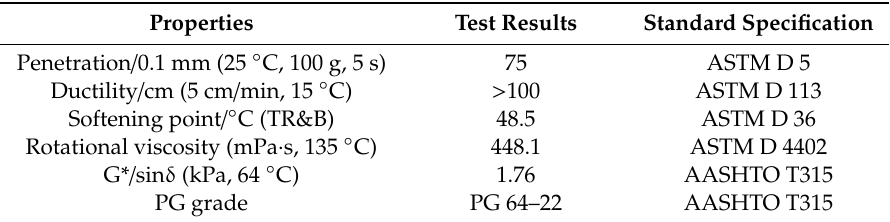
Table 1. Properties of the PG 64–22